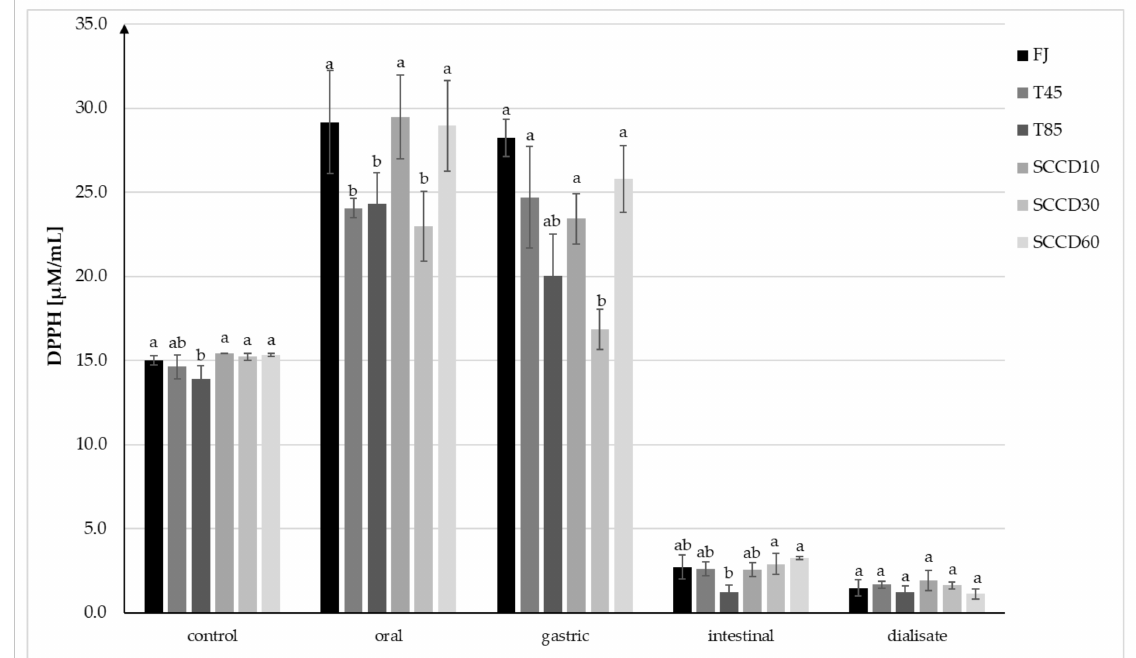
Figure 4. Antioxidant capacity (AC) of blackcurrant juice determined using the DPPH • assay at each step of digestion after different processing: FJ-fresh juice; T45-thermal treated juice at 45 ◦ C; T85-thermal treated juice at 85 ◦ C; SCCD10-juice after super critical carbon dioxide at 10 MPa; SCCD30-juice after super critical carbon dioxide at 30 MPa; SCCD60-juice after super critical carbon dioxide at 60 MPa. (The same letter above the bars indicates no significant difference between the mean ( p ≤ 0.05) within each digestion